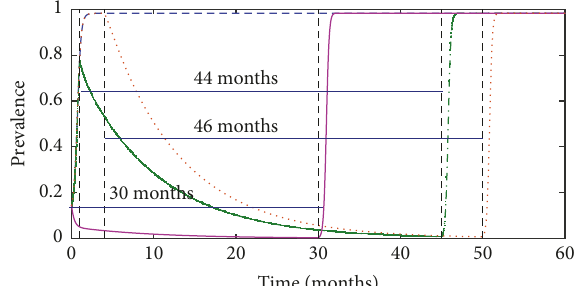
Figure 4: Plot for disease prevalence when all controls are intro- duced at 𝑡 = 0,1,2 months since infection.